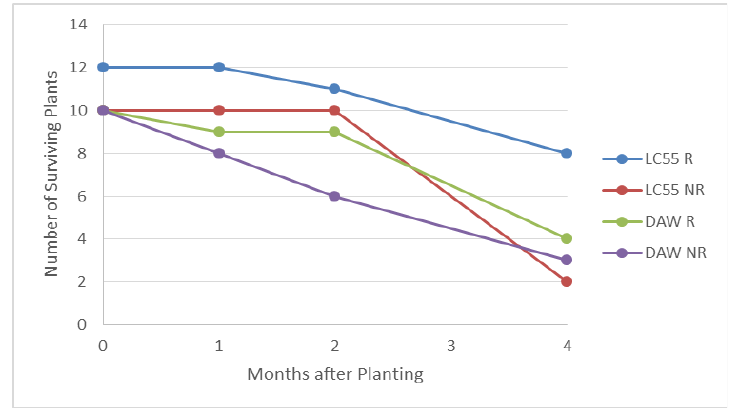
Figure 5. Xerophyllum asphodeloides shoot growth and rooting after 1 month in greenhouse potting mix. ( A ) DF-1 non-rooted. ( B ) DF-1 rooted. ( C ) LC-55 non-rooted. ( D ) LC-55 rooted.